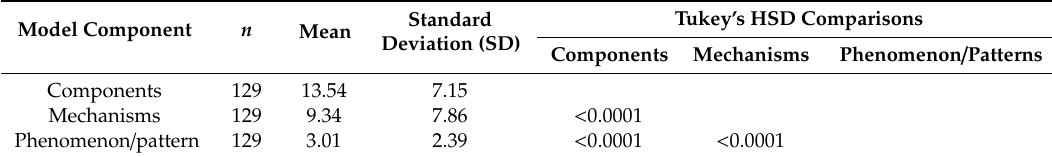
Table 4. Tukey’s honestly significant di ff erence (HSD) comparisons for article and model components.